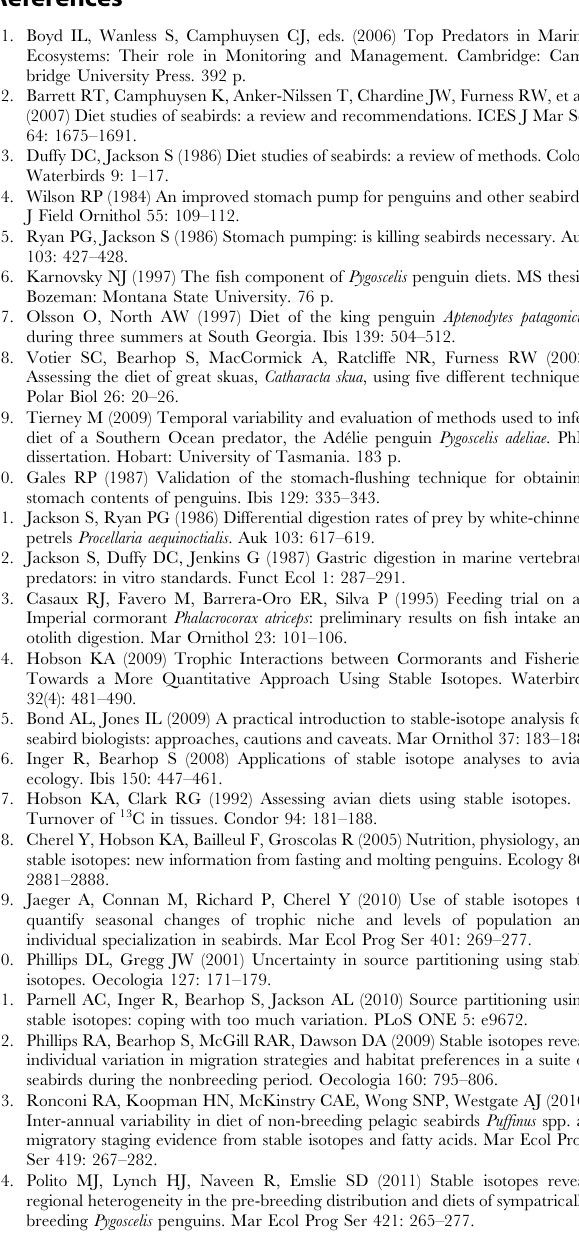
Table S1 The composition and reconstituted mass of fish species identified from otoliths in Chinstrap and Gentoo penguin stomach contents. Table S2 Discrimination factors, sample sizes, isotope values and elemental concentrations of prey source inputs into SIAR mixing